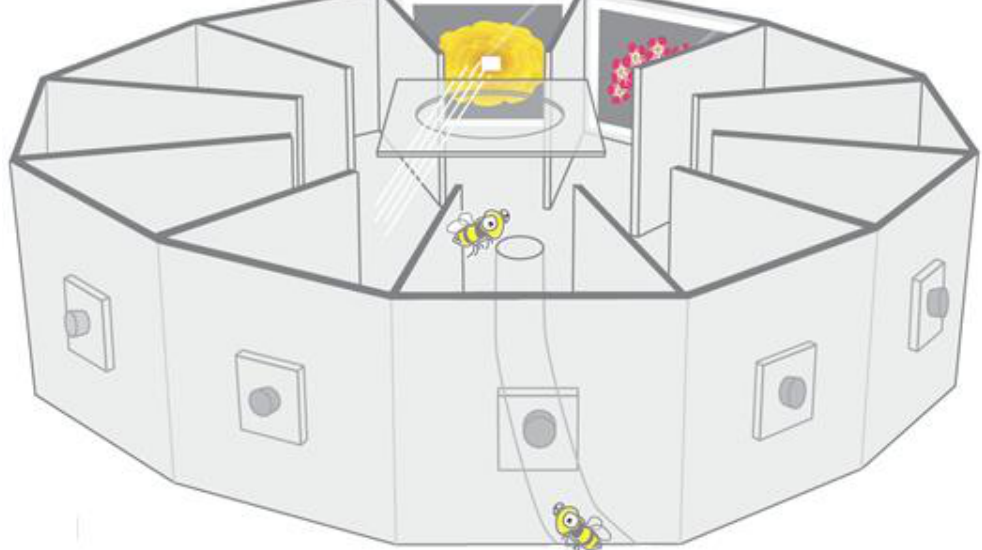
Figure 1 . Diagram of bee entering maze through hole in the floor using wire mesh tunnel. Stimuli are mounted on the back walls of the corridors. Figure modified from an original (Plowright et al., 2013) with kind permission from Springer Science and Business